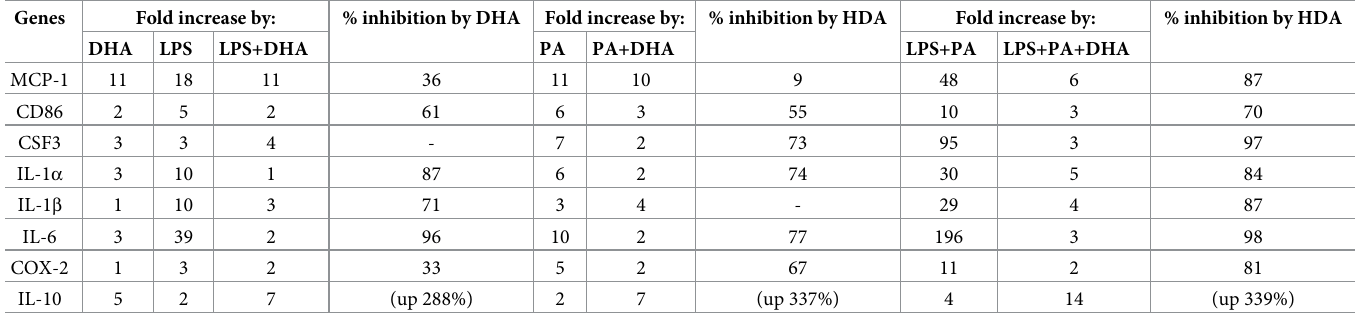
Table 1. The effect of DHA on gene expression stimulated by LPS, PA or LPS plus PA. Genes Fold increase by: % inhibition by DHA Fold increase by: % inhibition by HDA Fold increase by: